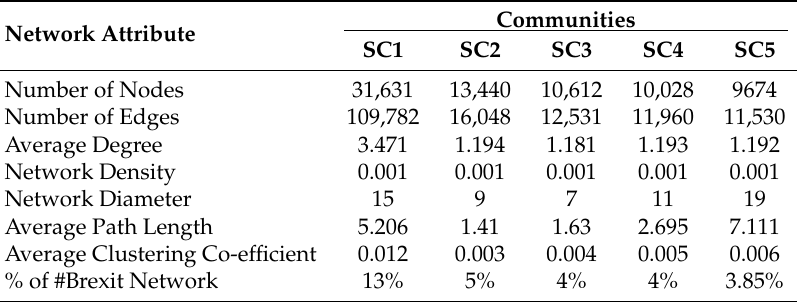
Table 3. Descriptive Network Statistics for